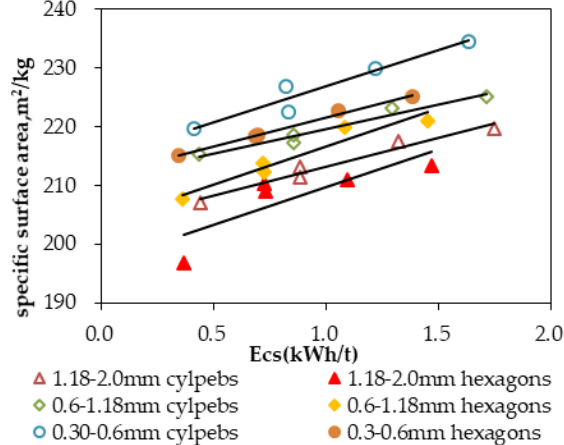
Figure 9. Relationship between specific surface area and specific energy.